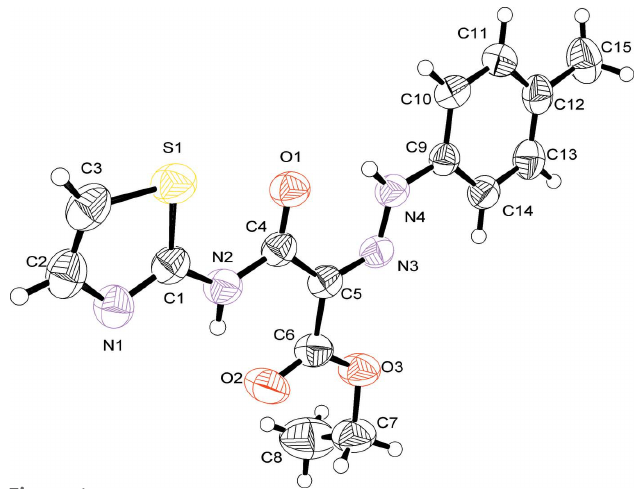
Figure 1 The molecular structure showing 50% displacement